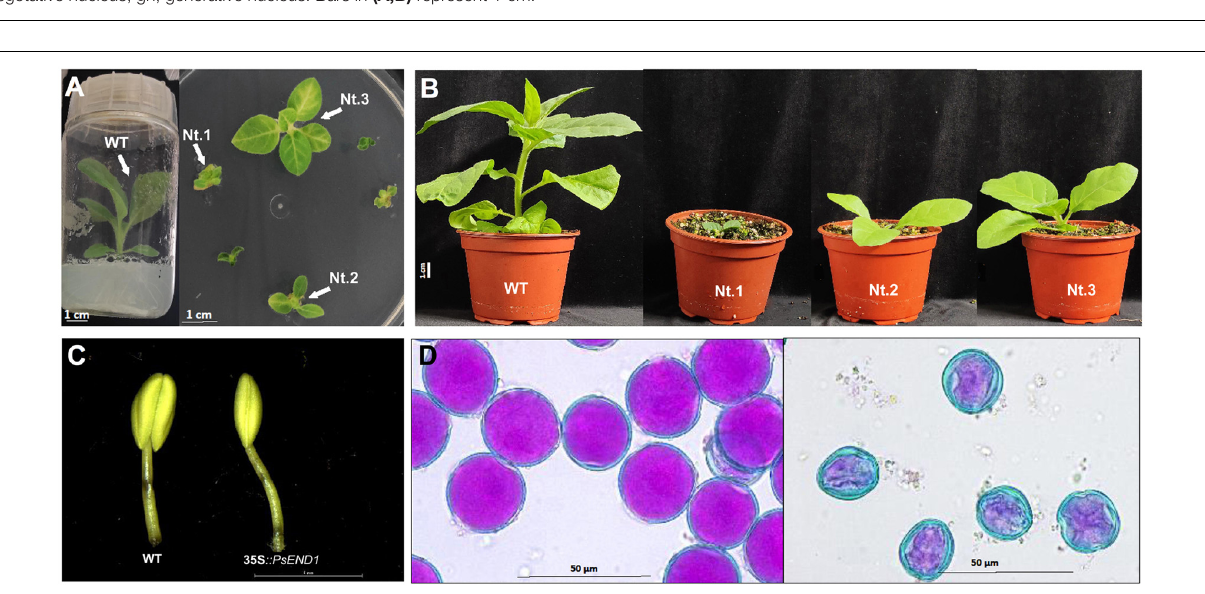
FIGURE 6 | Phenotypes of transgenic tobacco plants overexpressing PsEND1. (A) Tobacco plants 8 weeks after transformation. The control plant (left) has elongated and rooted and are ready to be acclimatized. The transgenic plants (right) are still much smaller and have not elongated nor rooted, yet. (B) Wild type (WT) and transgenic (Nt1, Nt2, and Nt3) tobacco plants 1 week after acclimatization in the greenhouse. The transgenic plants are smaller than the control. (C) Anthers of the transgenic plants (right) are smaller and lack two locules. (D) Alexander’s staining of pollen grains from the control (left) and transgenic tobacco plants (right). Viable pollen is round-shaped and stained in